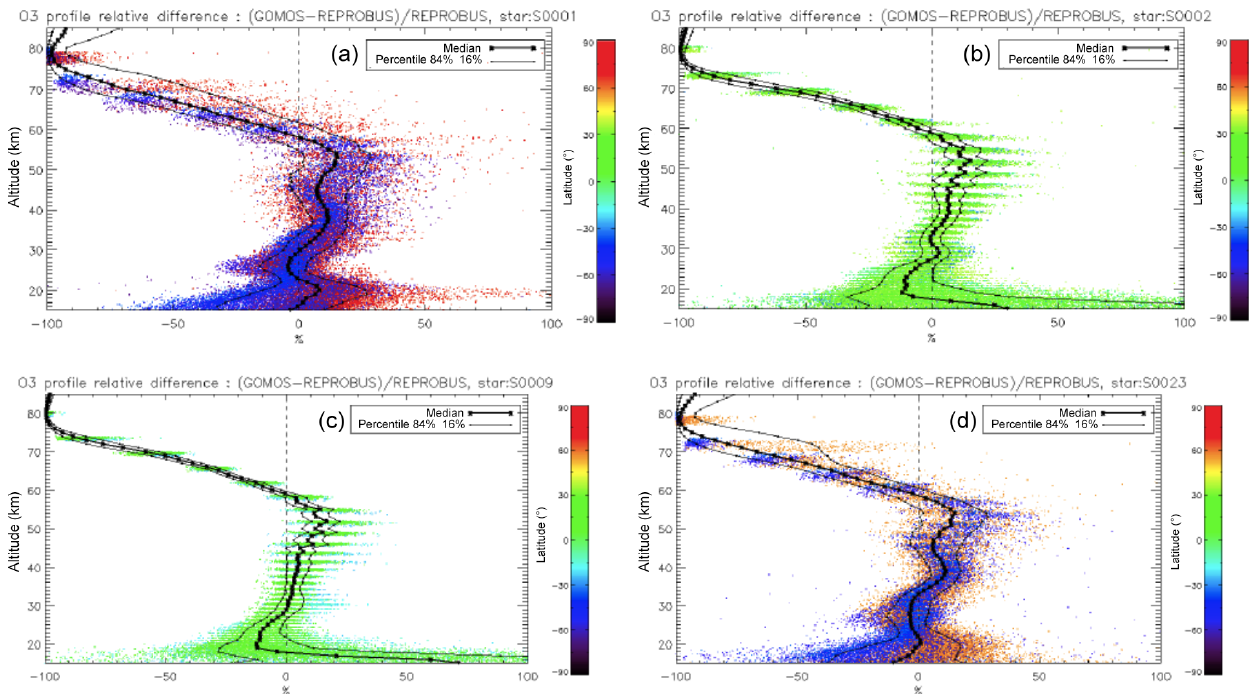
Figure C2. Relative difference between the GOMOS and REPROBUS ozone nighttime profiles for all 2007 occultations of the four brightest stars (S0001, S0002, S0009, and S0023), represented here, respectively, in panels (a) , (b) , (c) , and (d) . Each dot represents one GOMOS measurement of ozone. The colour of the dot is related to the latitude of each profile (see the colour scale). The thick black line represents the median and the thin black lines represent the 16th and 84th percentiles of the distribution of the relative difference.